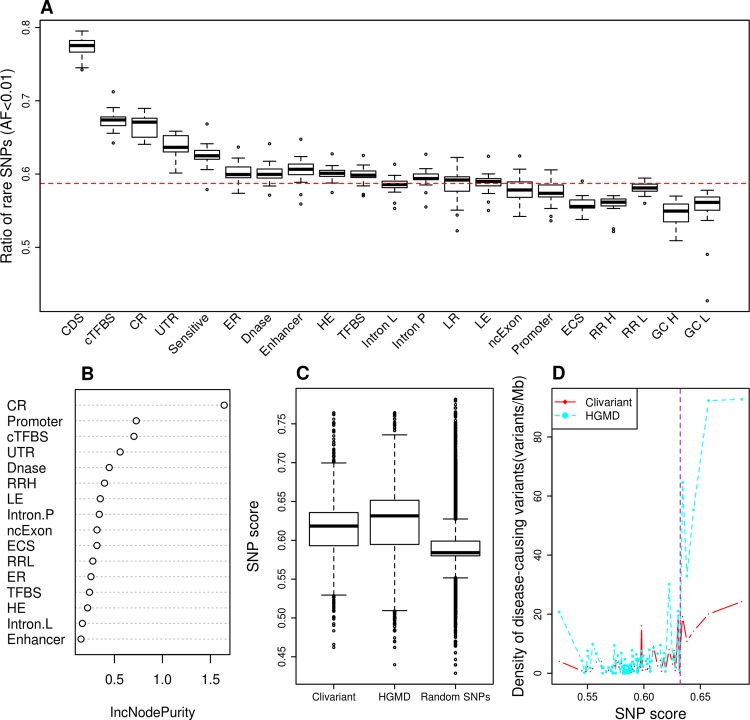
Construction of the rare SNP model.
A. Fraction of rare SNPs (allele frequency <0.01) according to different genome features (see S1 Table and Methods for feature details). Each box shows rare SNP fraction across all human chromosomes, except chr. Y. CDS: coding sequence; cTFBS: conserved transcription factor binding site; CR: evolutionarily conserved region; UTR: untranslated region; Sensitive: region with high rate of rare SNP defined in [10], ER/LR: early and late replicated region; DNase: DNase I hypersensitive site; HE/LE: high and low expressed region; Intron L/Intron P: intron of lncRNA/of protein coding gene; ncExon: non coding exon; ECS: evolutionarily conserved structure; RR H/RR L/GC H/GC L: high recombination rate, low recombination rate, high GC content and low GC content regions. The red dotted line represents the average fraction of rare SNPs across the genome. B. Feature importance as measured by IncNodePurity. We only show here features that passed feature selection. C. Distribution of SNP scores for random SNPs and for clinical variants from the Clivariants and HGMD databases. Random SNPs here are a set of 1M random intergenic SNPs from the 1000 Genome project. D. Correlation of SNP scores with densities of disease-causing variants. Genome positions were sorted by SNP score and split into 20 Mb intervals. The plots show the average SNP score and density of disease-causing variants for each interval. The purple dotted line shows cutoff used for defining high SNP score thereafter.